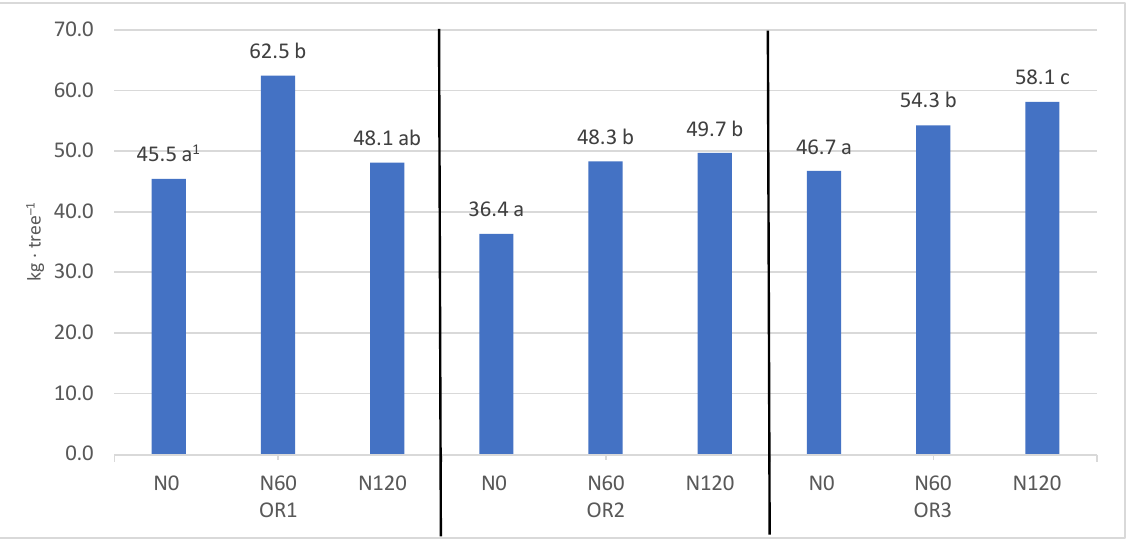
Figure 2. Total fruit yield in the years 2006–2013 (kg·tree –1 ). 1 means that the same letters for each orchard are not significantly different at α = 0.05 (Duncan’s test). Table 4. Yield of sour cherries of the ‘Łutówka’ cultivar in the years 2006–2013 depending on the year and fertilization (kg·tree −1 ).